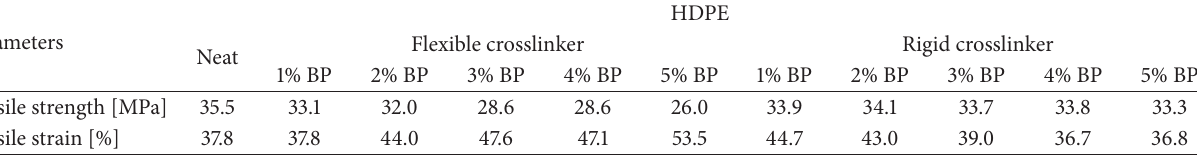
Table 5: The mechanical properties for the HDPE/BP injected sample.